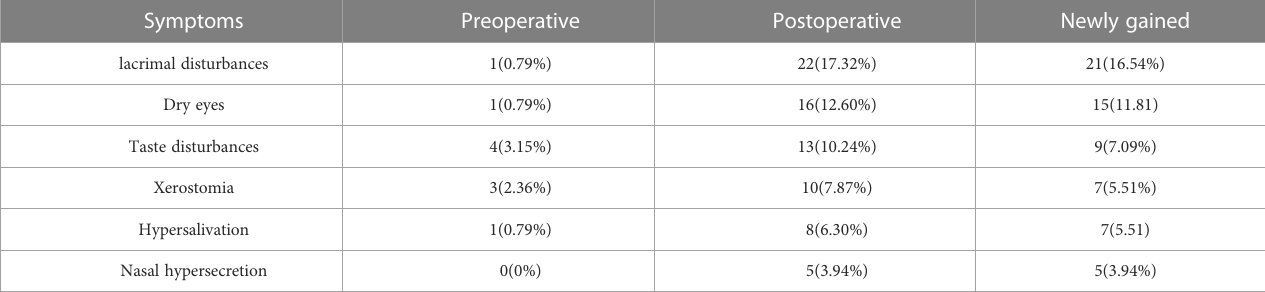
TABLE 3 Summary of the symptoms of preoperative, postoperative, and newly gained NI dysfunction.